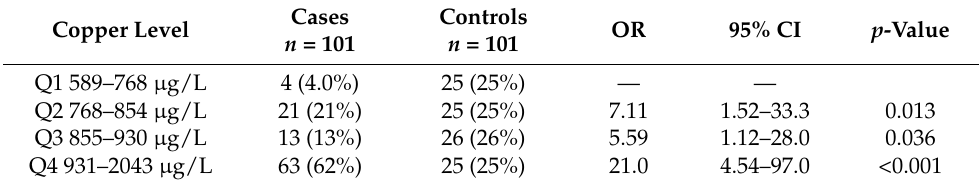
Table 6. Blood copper levels and the occurrence of stage I–II colorectal cancer.